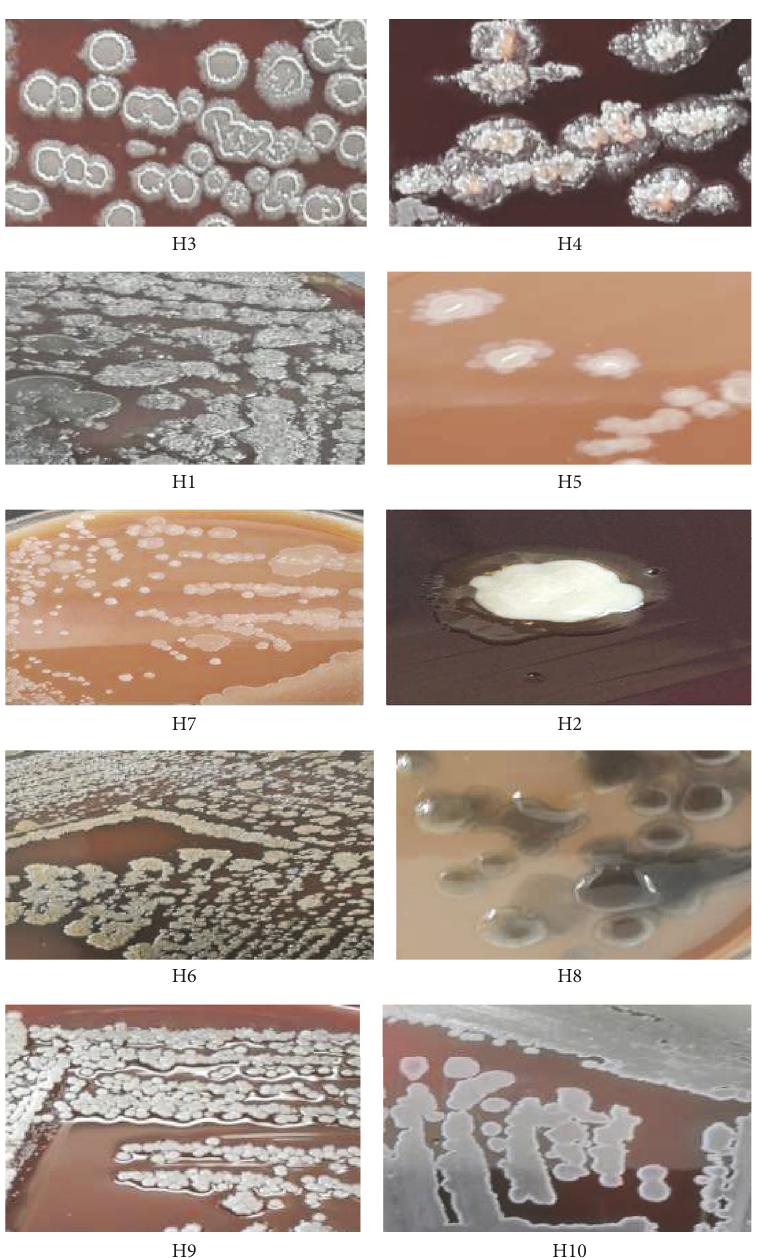
Figure 1: Variation in colonial morphology of bacterial isolates from the hot springs using 5% sheep blood